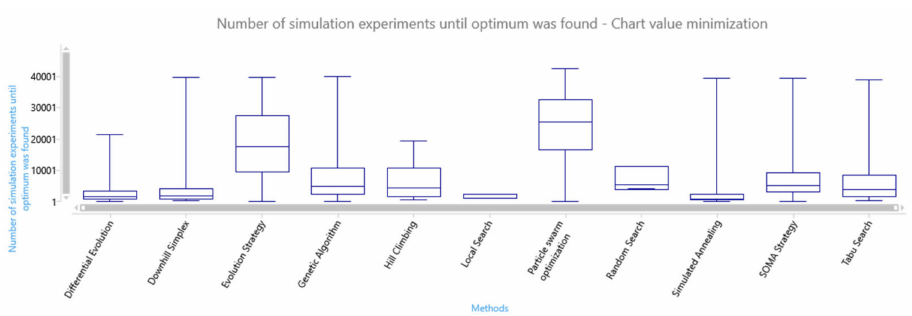
Figure 14. Box plot of the speed in finding a global optimum of the objective function.